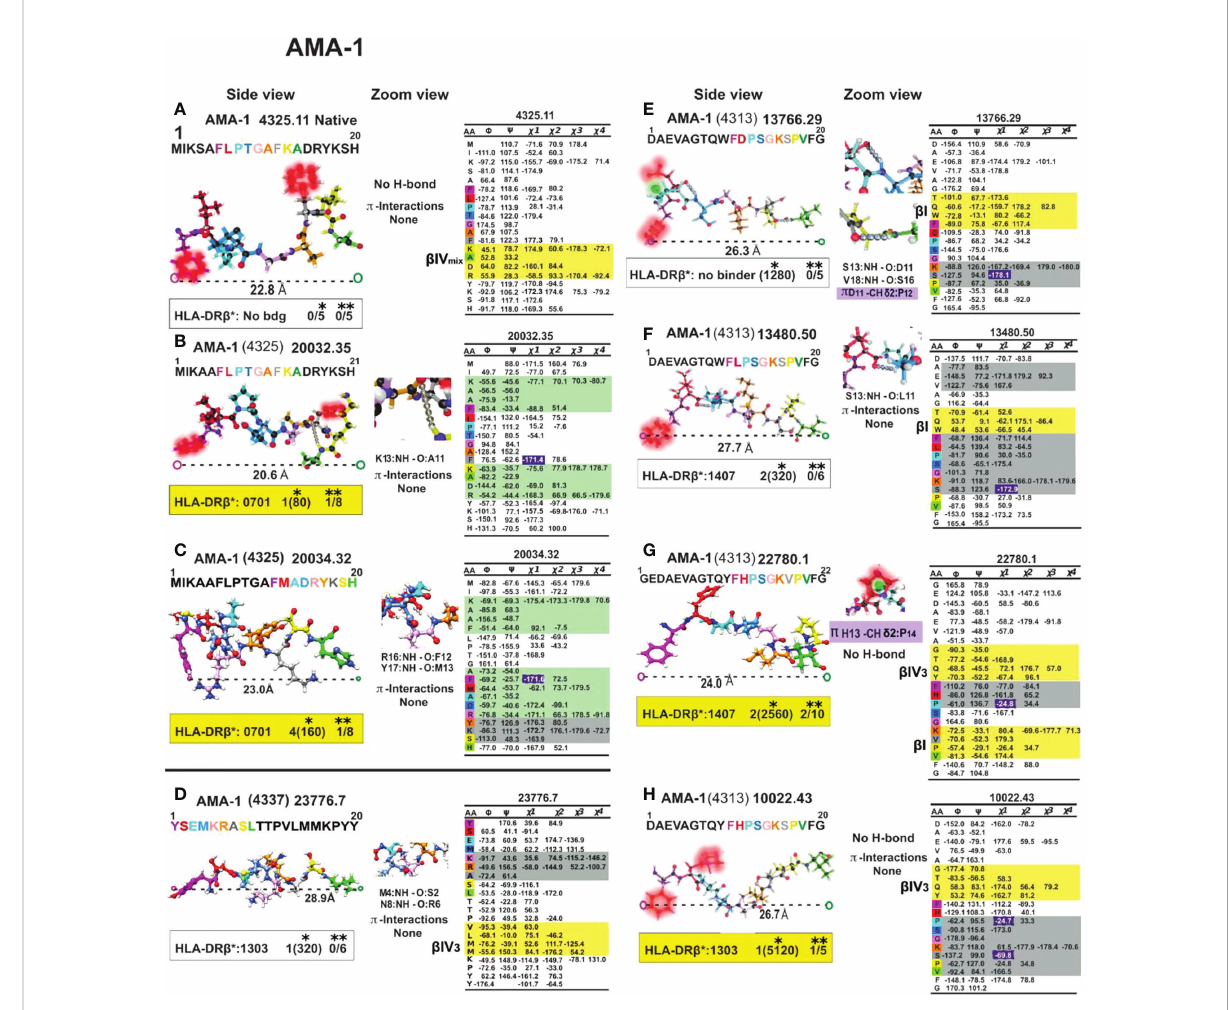
FIGURE 11 Colour code for peptide binding region, structural and interaction as in Figure 8. (*) Nr Monkeys (antibody titers) and (**) Nr of protected monkeys. AMA-1-derived cHABPs and mHABPs. Legend and conventions as in Figure